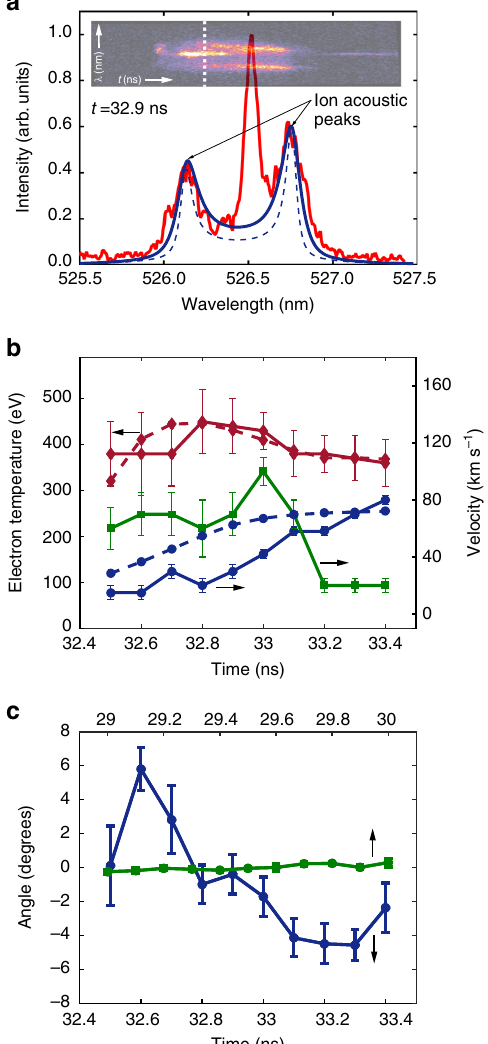
Fig. 3 Thomson scattering measurements. Electron temperatures and fl ow velocities are obtained by fi tting the experimental data with the frequency- dependent Thomson scattering cross-section 37 . In the fi tting procedure we assumed an electron density of ≲ 10 20 cm − 3 (as predicted by FLASH simulations). At these electron densities, the frequency distribution of the scattered light does not depend on the electron density, which only provides an overall normalization factor. a Thomson scattering data (red solid line) at t = 32.9 ns obtained from a target driven with the 5 ns pulse pro fi le. The blue dashed line corresponds to plasma in thermodynamic equilibrium (assuming equal electron and ion temperatures). The central peak is due to stray light at the probe laser wavelength (and it is used to determine the instrumental resolution of the spectrometer). The blue solid line corresponds to the case in which additional broadening due to turbulence is included in the fi tting procedure. The inset in the top panel shows the time-streaked image of the Thomson scattered light. The resolution of the streak camera is ~50 ps and the Thomson scattering signal is fi tted every 100 ps. b Flow velocity towards grid B (full blue circles), turbulent velocity (full green squares), and electron temperature (full red diamonds) as measured by Thomson scattering for the case of a target driven with the 5 ns laser pro fi le. FLASH simulation results for the electron temperature and fl ow velocity in the probe volume are also reported in dashed lines. The error bars are estimated from the χ 2 fi t of the data. c Estimated Faraday rotation data from the Thomson scattering data. This was done by separating the scattered light into two orthogonal polarizations (see Supplementary Methods). The blue line corresponds to the same conditions as b , above. The green line was obtained from an experiment involving a single- fl ow, single-grid experiment only, when the magnetic fi eld is expected to be signi fi cantly smaller (see Supplementary Figure 8 for the proton radiography results arising for a single- fl ow, single- grid experiment). The errors are determined by the standard deviation of the data within the